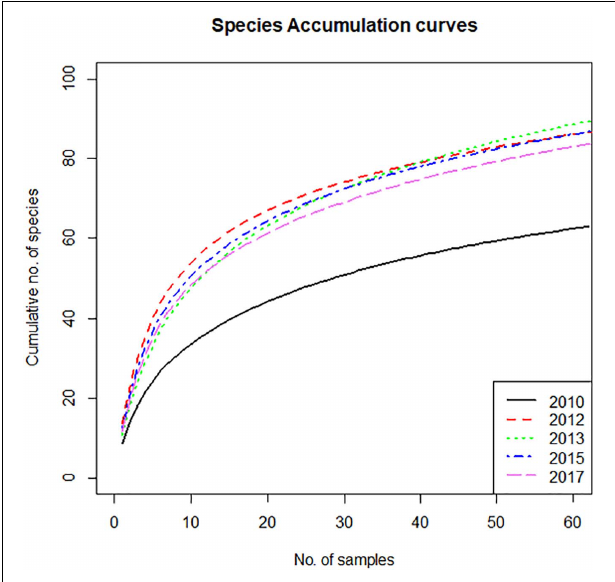
FIGURE 3 | Species accumulation curves, showing the expected cumulative number of species as a function of number of samples, for the year before construction of the Sand Motor (2010) and several years after